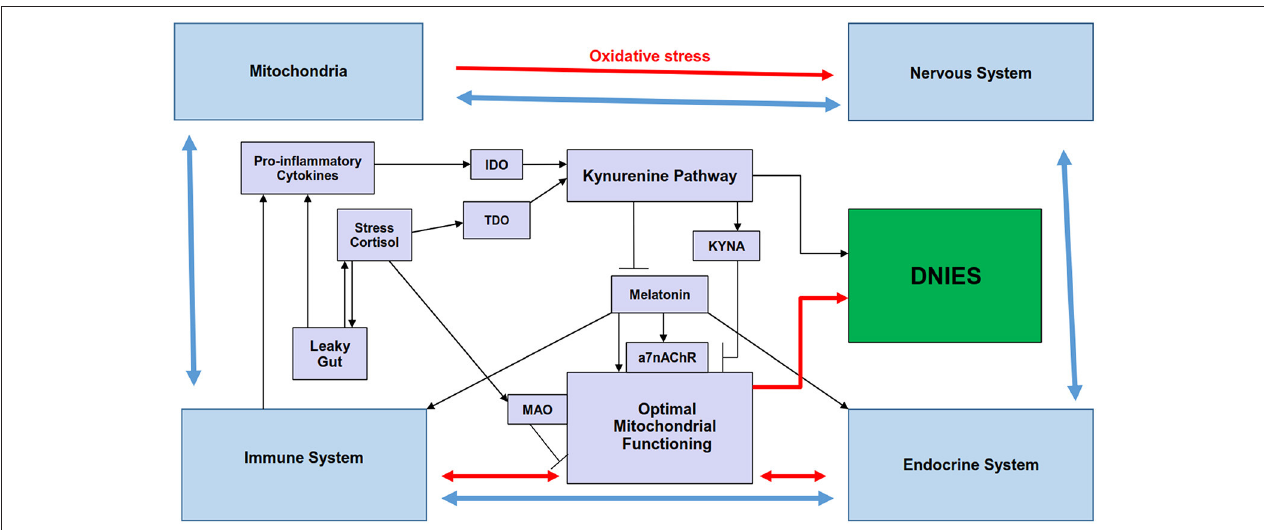
FIGURE 1 | Summary scheme showing how the regulation of melatonin and the kynurenine pathways by stress and inflammation may be involved in the reciprocated interactions of mitochondria and the immune, endocrine, and nervous systems that comprise the diffuse neuroimmunoendocrine system (DNIES). Pro-inflammatory cytokines and chronic stress increase IDO and TDO, respectively, leading to kynurenine pathway induction, with differential effects on mitochondrial functioning (black lines). Kynurenine pathway activation and stress-induced MAO, by decreasing serotonin availability, decrease melatonergic pathway activation, thereby contributing to suboptimal mitochondrial functioning. KYNA inhibits the a7nAChR, thereby inhibiting some of melatonin’s effects, which may be mediated via the a7nAChR (black lines). The interactions of the endocrine, immune and nervous systems (blue lines) are modulated by mitochondrial functioning (red lines), with the effects of these systems and their interactions differentially feeding back on mitochondrial functioning in different cells of these systems. Such reciprocated interactions form the DNIES. The kynurenine pathway is also intimately connected to the component systems of DNIES. a7nAChR, alpha 7 nicotinic receptor; IDO, indoleamine 2,3-dioxygenase; MAO, monoamine oxidase; TDO, tryptophan